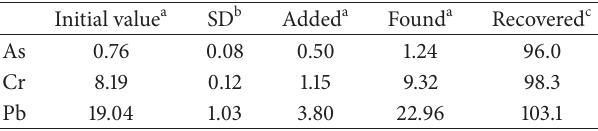
Table 3: Results of the validation by standard addition carried out in A. dubius . Initial value a SD b Added a Found a Recovered c As 0.76 0.08 96.0